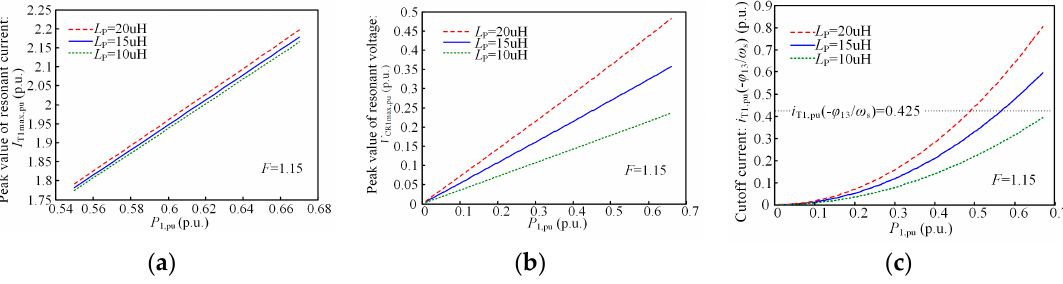
Figure 8. Circuit operating characteristics versus P 1,pu under varying L P : ( a ) I T1max,pu ; ( b ): V CR1max,pu ; ( c ): i T1,pu ( − ϕ 13 / ω s ).